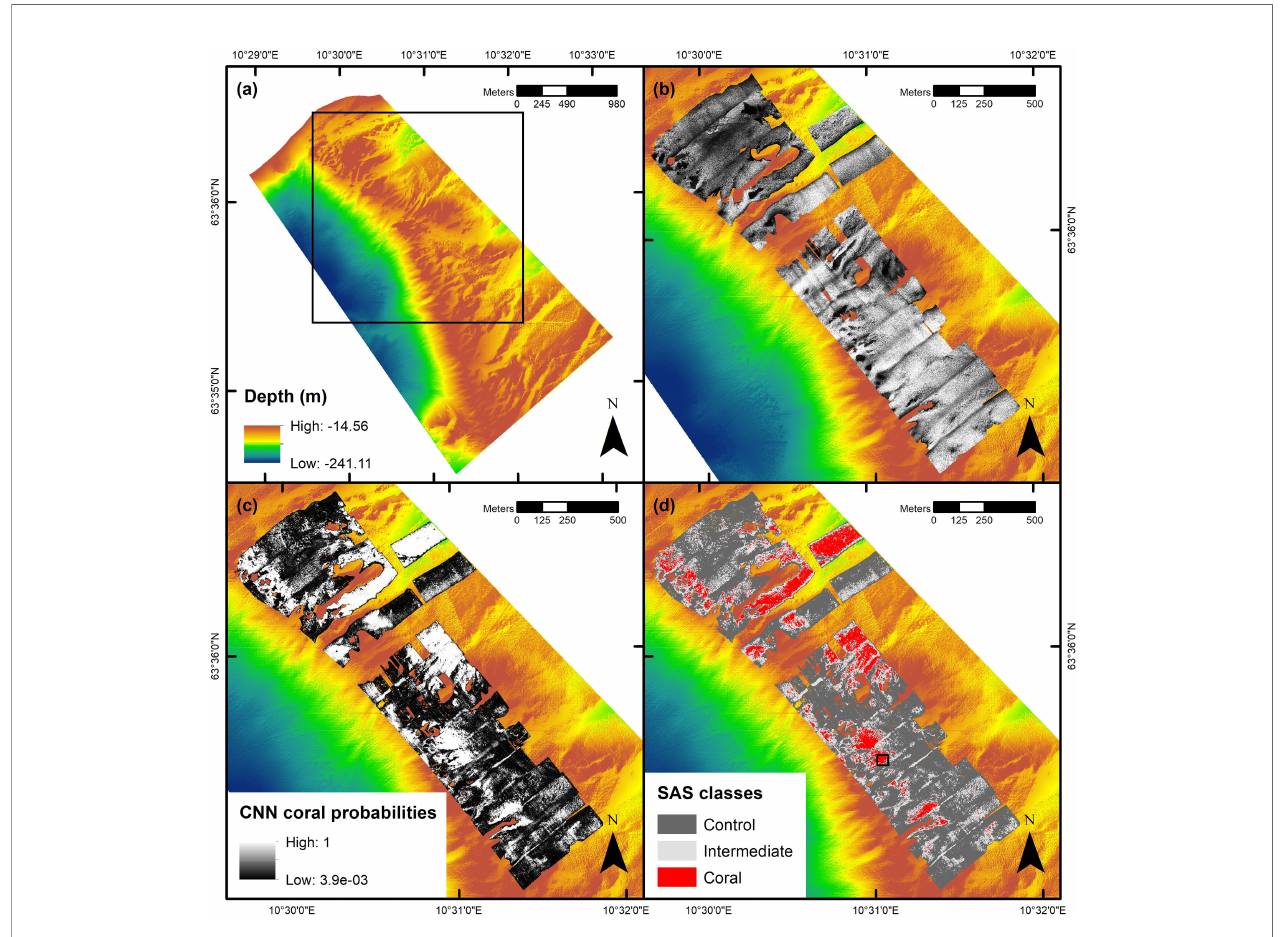
FIGURE 3 | Multibeam echo sounding (MBES) and synthetic aperture sonar (SAS) imaging results. Panel (A) shows the MBES-derived bathymetric map of the most pronounced part of the Tautra Ridge (declassi fi ed bathymetry, map courtesy of the Norwegian Mapping Authority). The black square indicates the spatial extent of panels (B-D). Panel (B) shows the Tautra Ridge SAS mosaic. Panel (C) shows the georeferenced probabilities of coral presence obtained from the convolutional neural network (CNN). Panel (D) shows the classi fi ed coral distribution map generated based on the probabilities in panel (C) and the thresholds de fi ned in Estimation of CWC Reef Distribution in SAS Imagery . The black square indicates the position of the underwater hyperspectral imaging (UHI) mosaic presented in Figure 4 . The maps were created in ArcMap (v. 10.8; Esri Inc., Redlands, USA; https://desktop.arcgis.com/en/arcmap/). Projection: UTM 32N. Datum: WGS